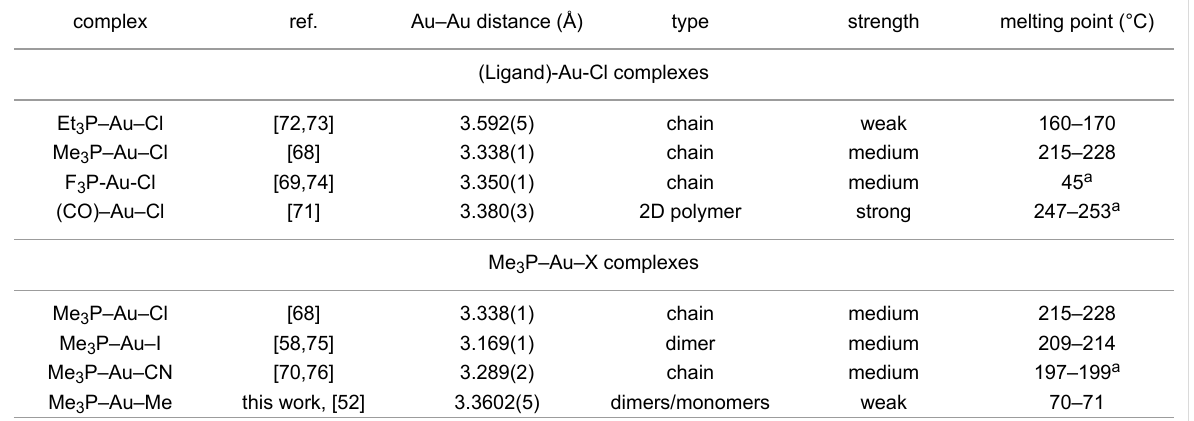
Table 1: Aurophilic Au–Au interactions in complexes of the type (ligand)–Au–Cl and Me 3 P–Au–X.